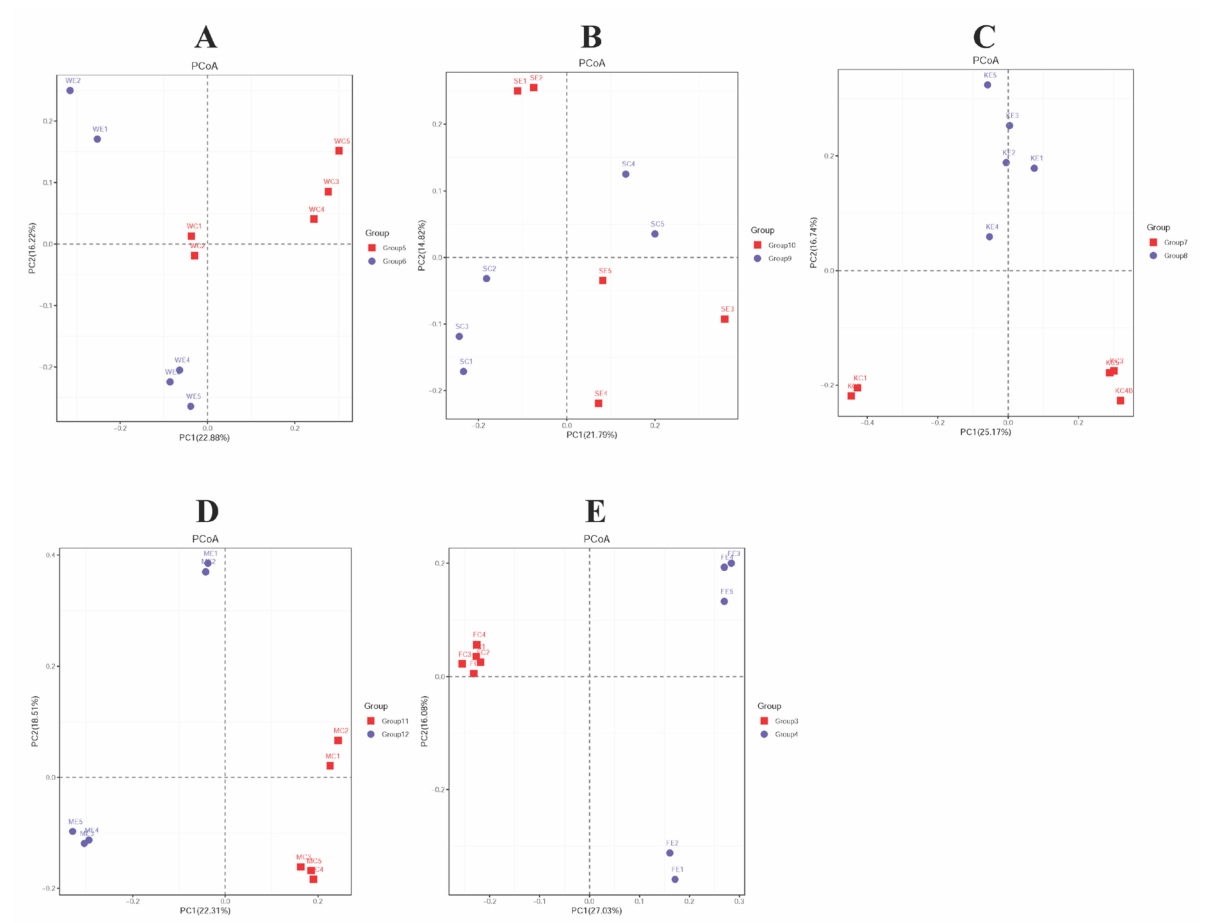
Figure 3. PCoA analysis of the efficacy of colistin on piglet gastrointestinal tract microbiome change. ( A ) Stomach (Group 6, Group 5); ( B ) duodenum (Group 10, Group 9); ( C ) jejunum (Group 8, Group 7); ( D ) cecum (Group 12, Group 11); ( E ) feces (Group 4, Group 3); colistin treated group: Group